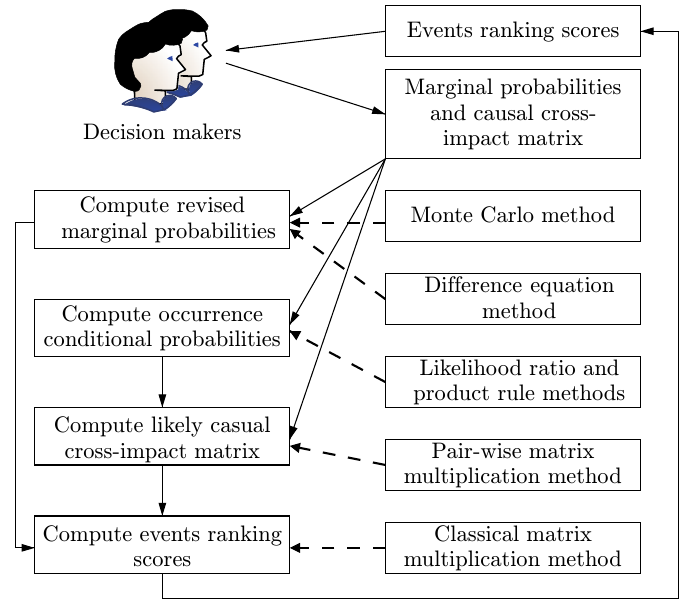
Figure 1: Architecture of the CIA system used in this